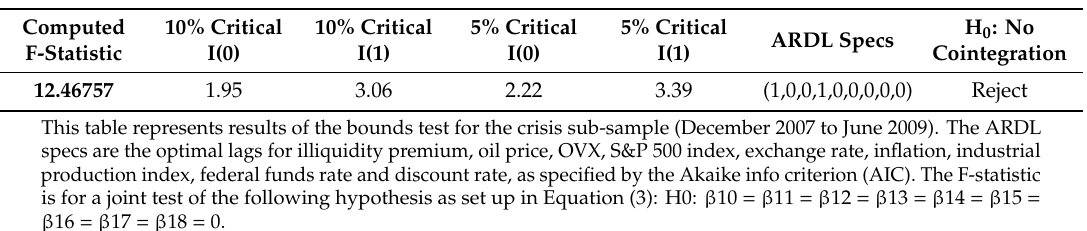
Table 17. The results of the bounds test for cointegration (financial crisis).